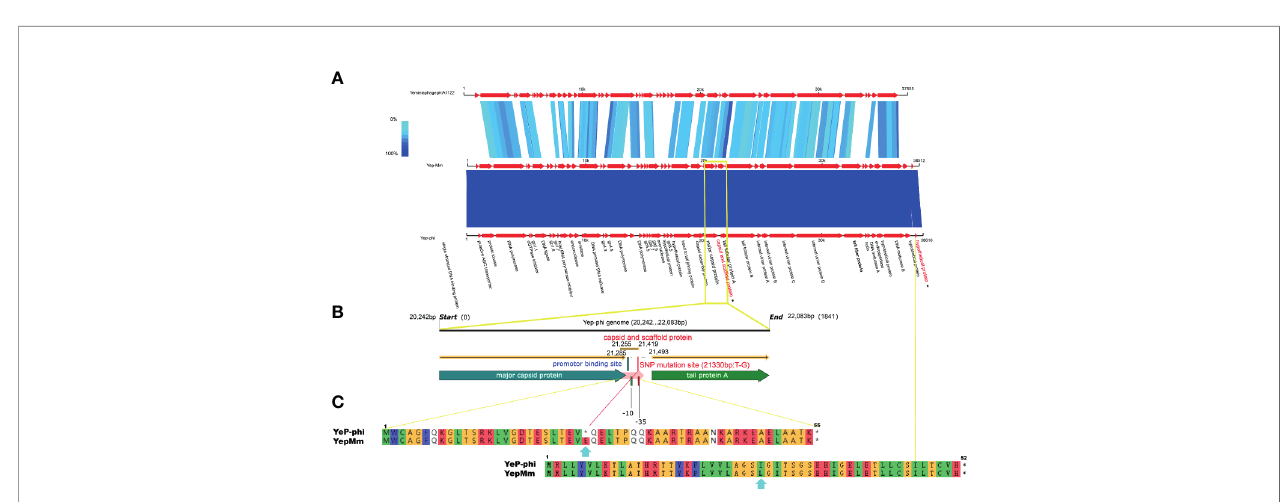
FIGURE 3 | The biological sequence analysis of the bacteriophages YepMm, Yep-phi, and phiA1122. (A) Pairwise comparison of the nucleotide sequences of bacteriophages YepMm, Yep-phi, and phiA1122 (the two different ORFs were indicated in asterisks). (B) The main difference between the two Y. pestis phages of YepMm, Yep-phi. The intergenic region and new ORFs with SNP mutation of YepMm was indicated in yellow rectangle. (C) The amino acid similarity alignment of the new ORF-29 of bacteriophages YepMm and